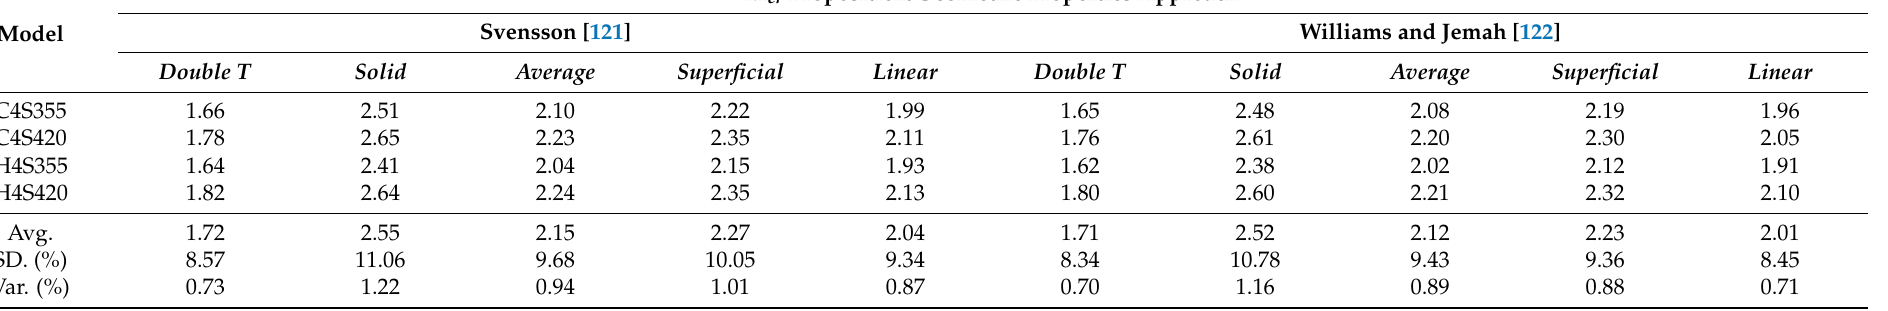
Table 15. M u-Theoretical / M u-test obtained by the calculation procedure of Salah’s M u proposition [58] with M cr calculation proposed by Svensson [121] and Williams and Jemah